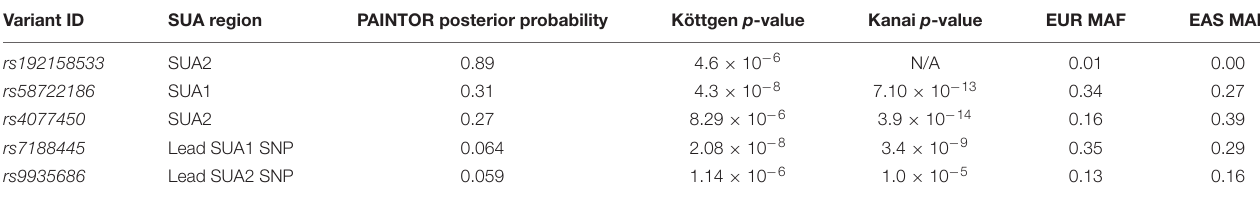
TABLE 3 | PAINTOR analysis of SUA1 and